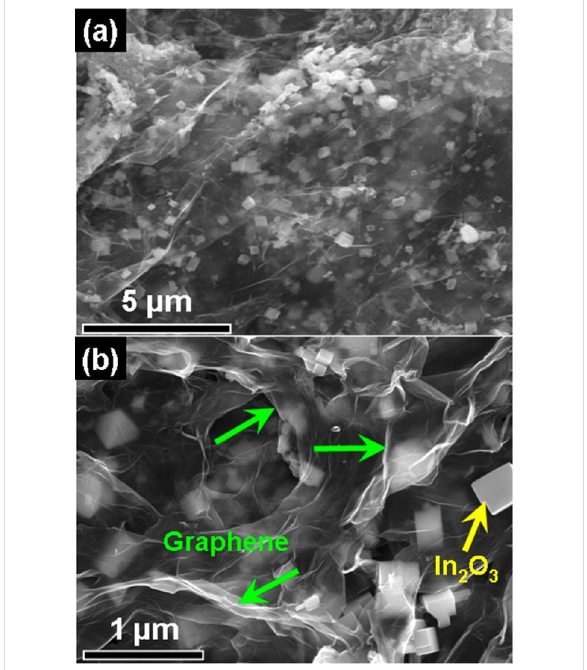
Figure 4: SEM images of the In 2 O 3 cubes-rGO composites at differ- ent magnification. Reproduced with permission from [80], copyright 2014 American Chemical